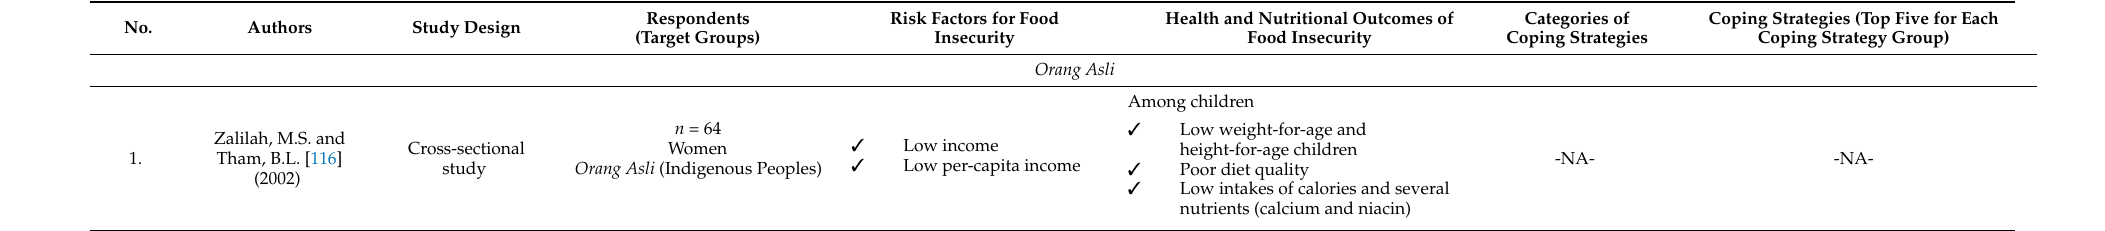
Table 4. Contributing factors, consequences, and coping strategies of food insecurity in Malaysia (40